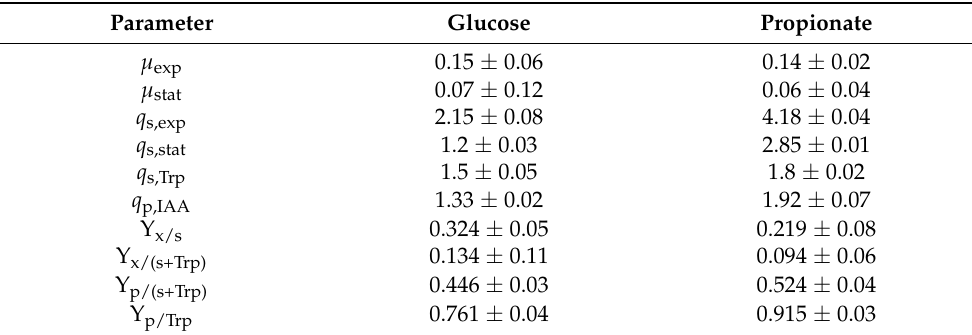
Table 1. Kinetics parameters of Bacillus subtilis cultivation in a 3 L bioreactor comparing two carbon sources, glucose and